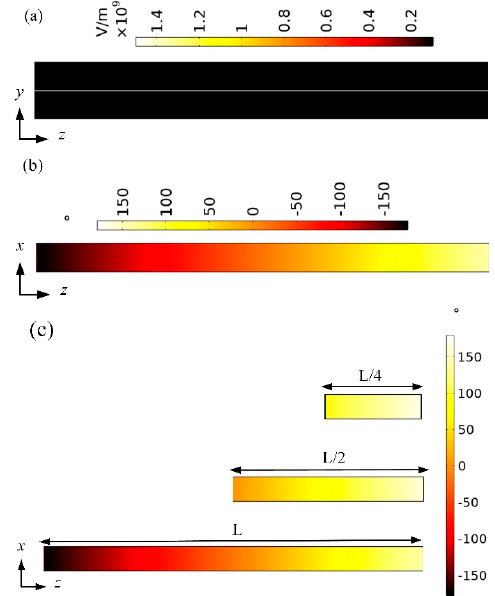
Figure 5. Simulation results of the proposed structure: ( a ) electric field distributions of SPPs guided by the proposed structure; ( b ) phase shift in the SPPs wave in the direction of transmission; ( c ) phase shift comparison of di ff erent transmission